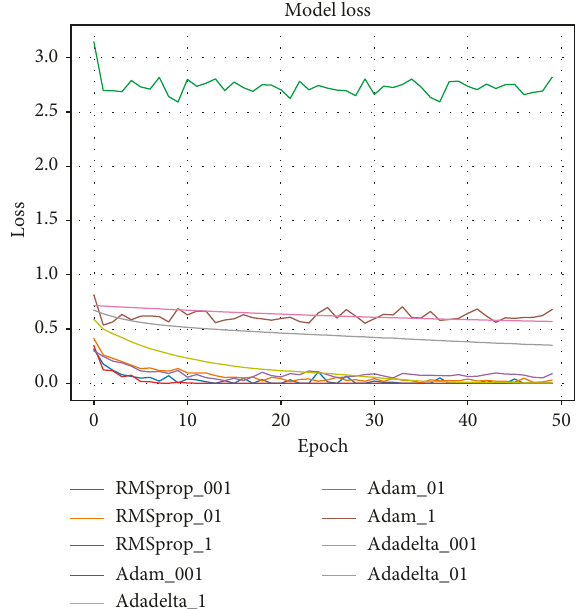
Figure 5: Loss change of different optimizers and learning